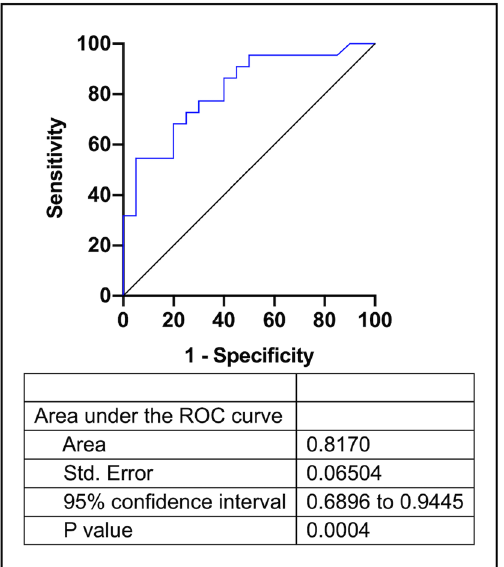
Figure 4. Receiver-operating characteristic curve comparing sensitivity and specificity for the binary logistic regression model.